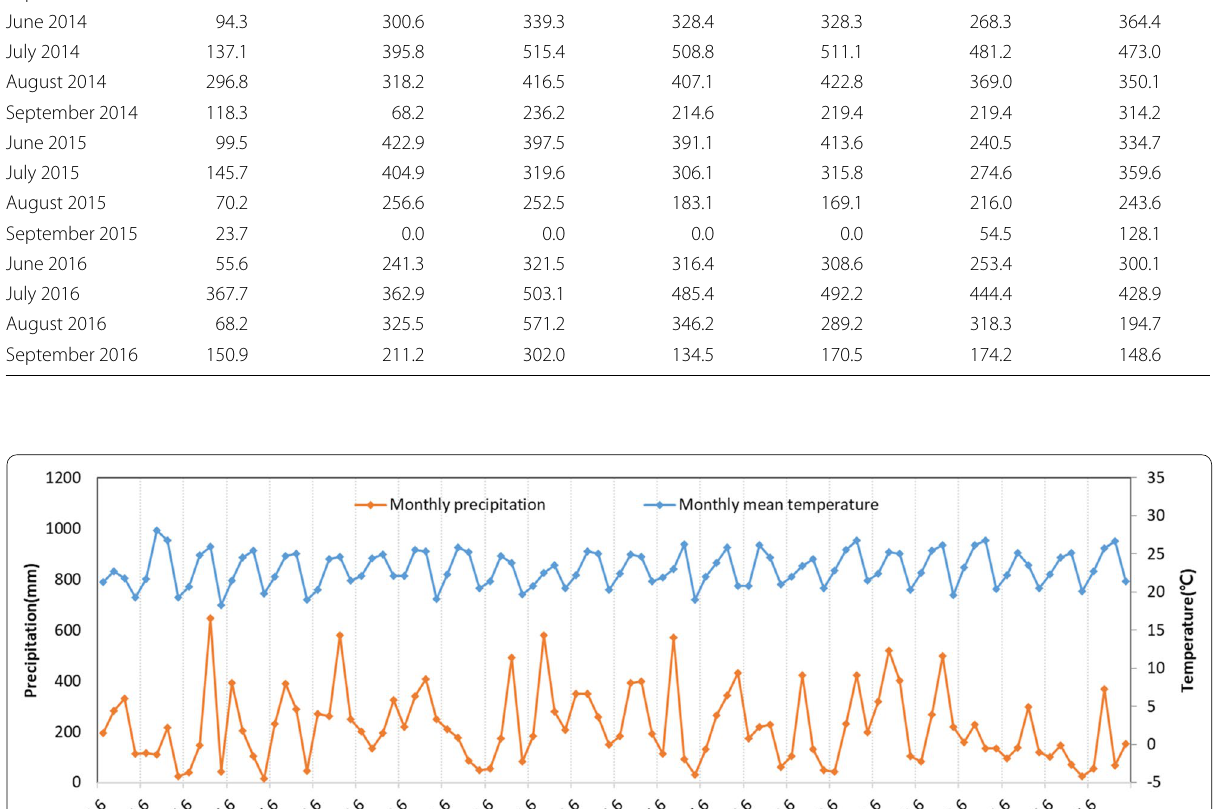
Table 11 Correlation coefficient according to the lead time using the modified method Lead time 1 month 2